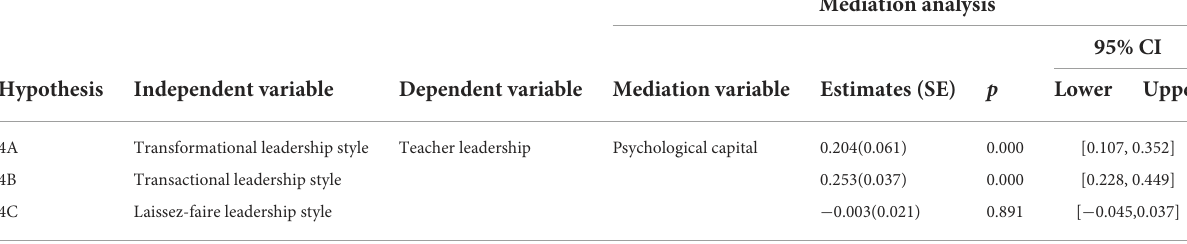
TABLE 4 Mediation analysis of psychological capital on the associations between principal leadership styles and teacher